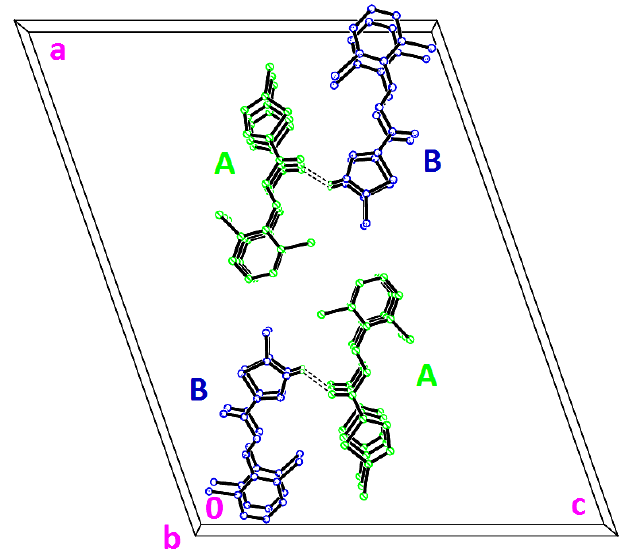
Figure 11. Crystal packing of 3i , viewed along the b -axis. Dashed lines indicate the intermolecular hydrogen